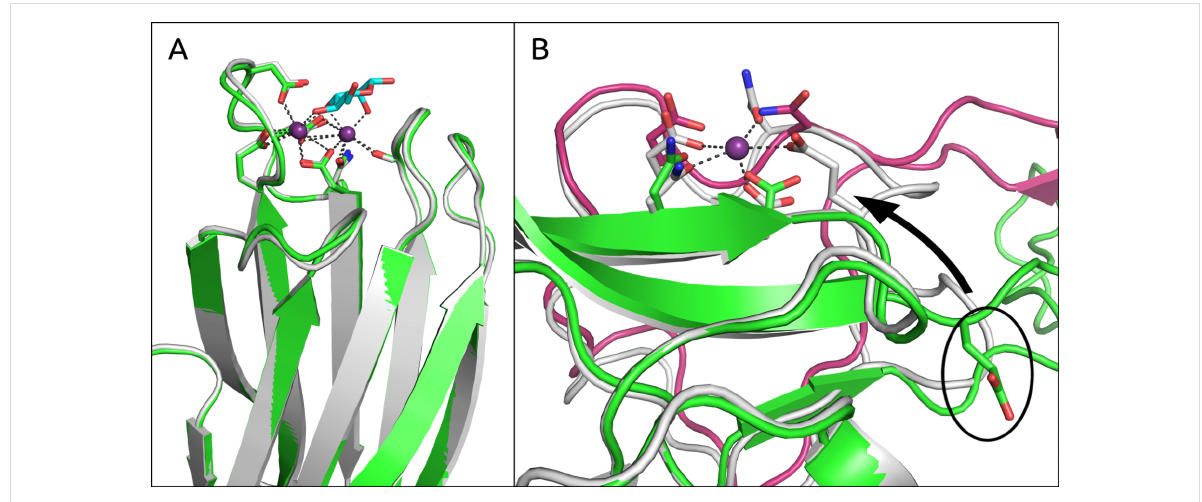
Figure 8: Comparison of the holo (white) and apo (green, magenta) binding sites of LecB ( G ) and BDCA-2 ( A ), respectively. A) The superimposition of both binding sites of G reveals nearly identical structures (RMSD of 0.3 Å). B) The binding site of A exhibits a flexible loop which enables homo- dimerization (chain A in green and chain B in magenta), in which a glutamate residue that is essential for Ca 2+ binding ends up projecting away from the binding site (illustrated for chain A). The situation is mirrored for chain B. Interestingly the loop from chain B closely mimics the binding site of the holo structure